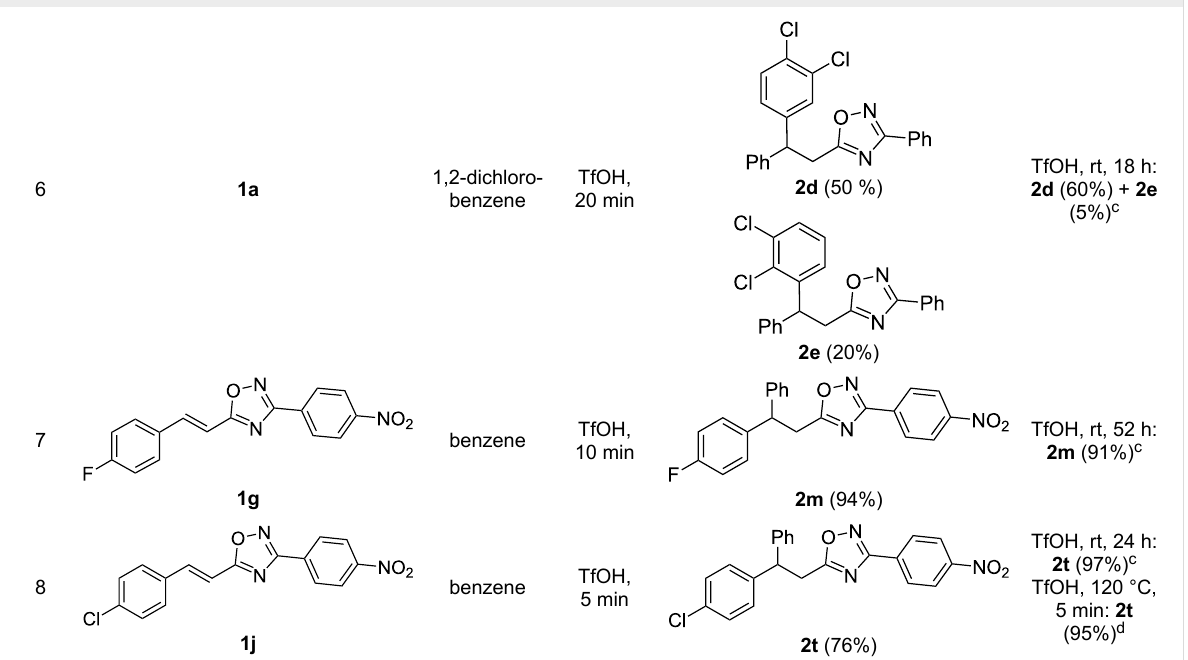
Table 3: Hydroarylation of oxadiazoles 1 with arenes under microwave (MW) activation in TFOH at 120 °C. (continued)